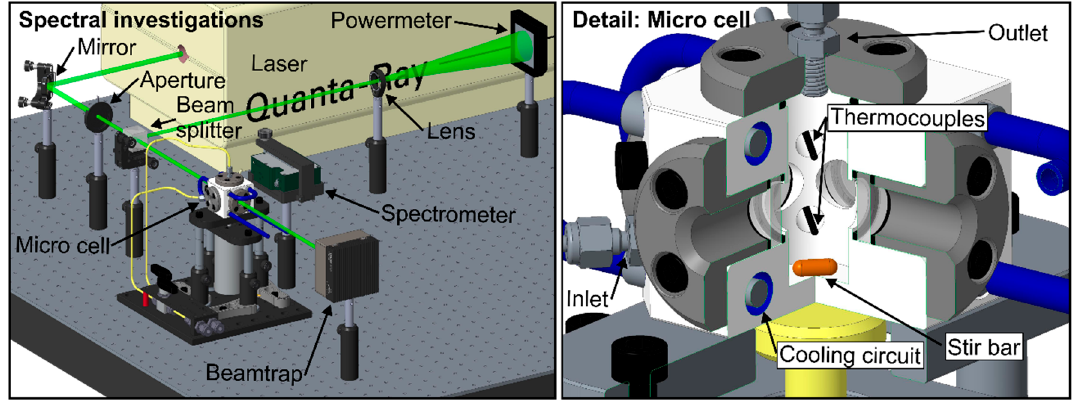
Figure 1. Optical setup ( left ) and internal design (sectional view) of the micro cell ( right ).